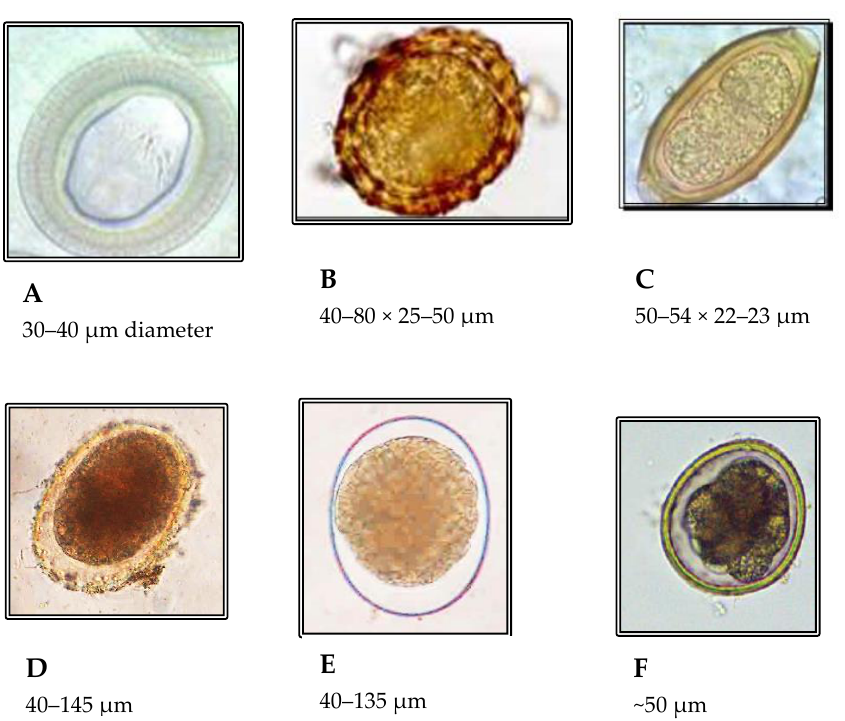
Figure 2. Electron micrograph images of Taenia spp. egg ( A ) [62], Ascaris lumbricoides egg ( B ) [70], Trichuris trichiura egg ( C ) [70], plant pod ( D ) [71], insect or spore ova ( E ) [71], Toxocara cati egg ( F ) [72].